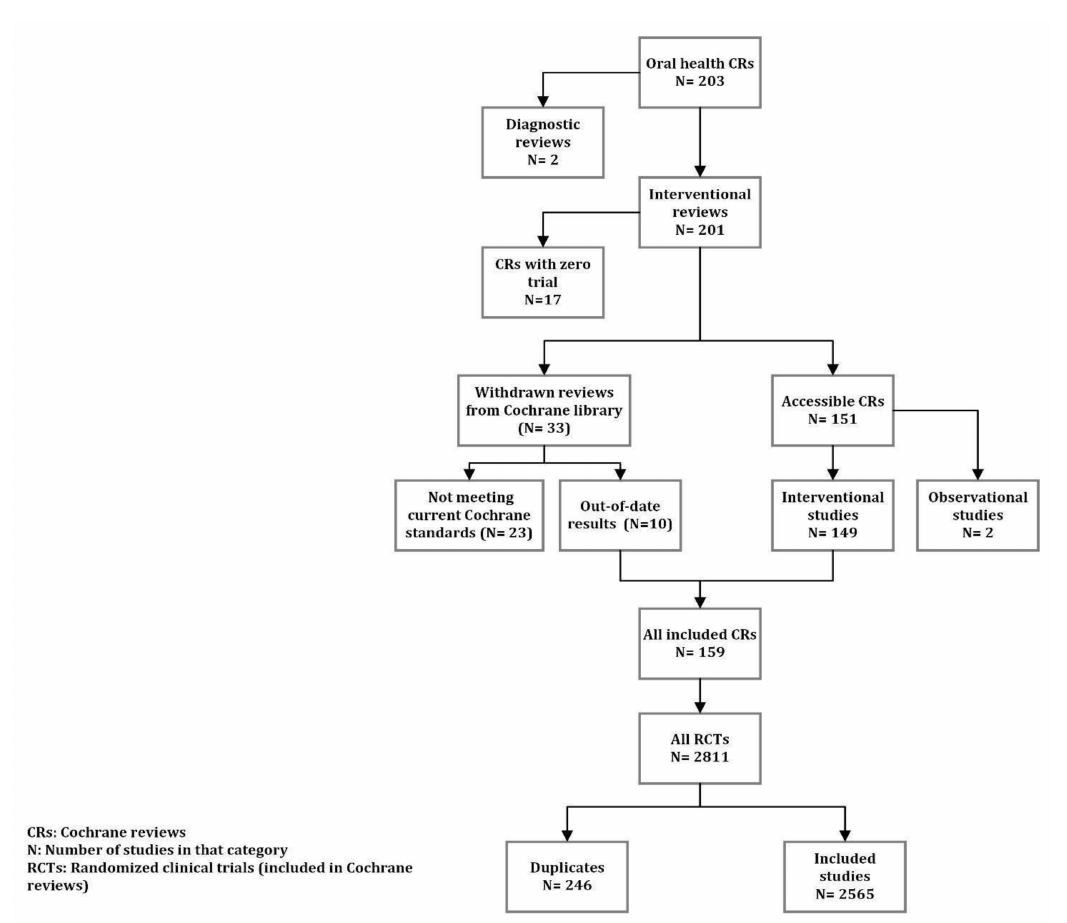
Figure 1. Flowchart for study selection